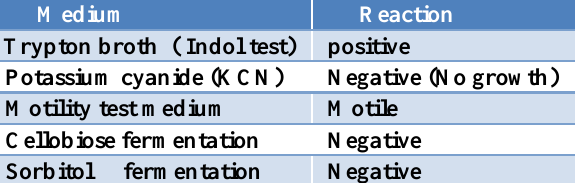
Table, 2: Biochemical properties of E.coli O157 :H7